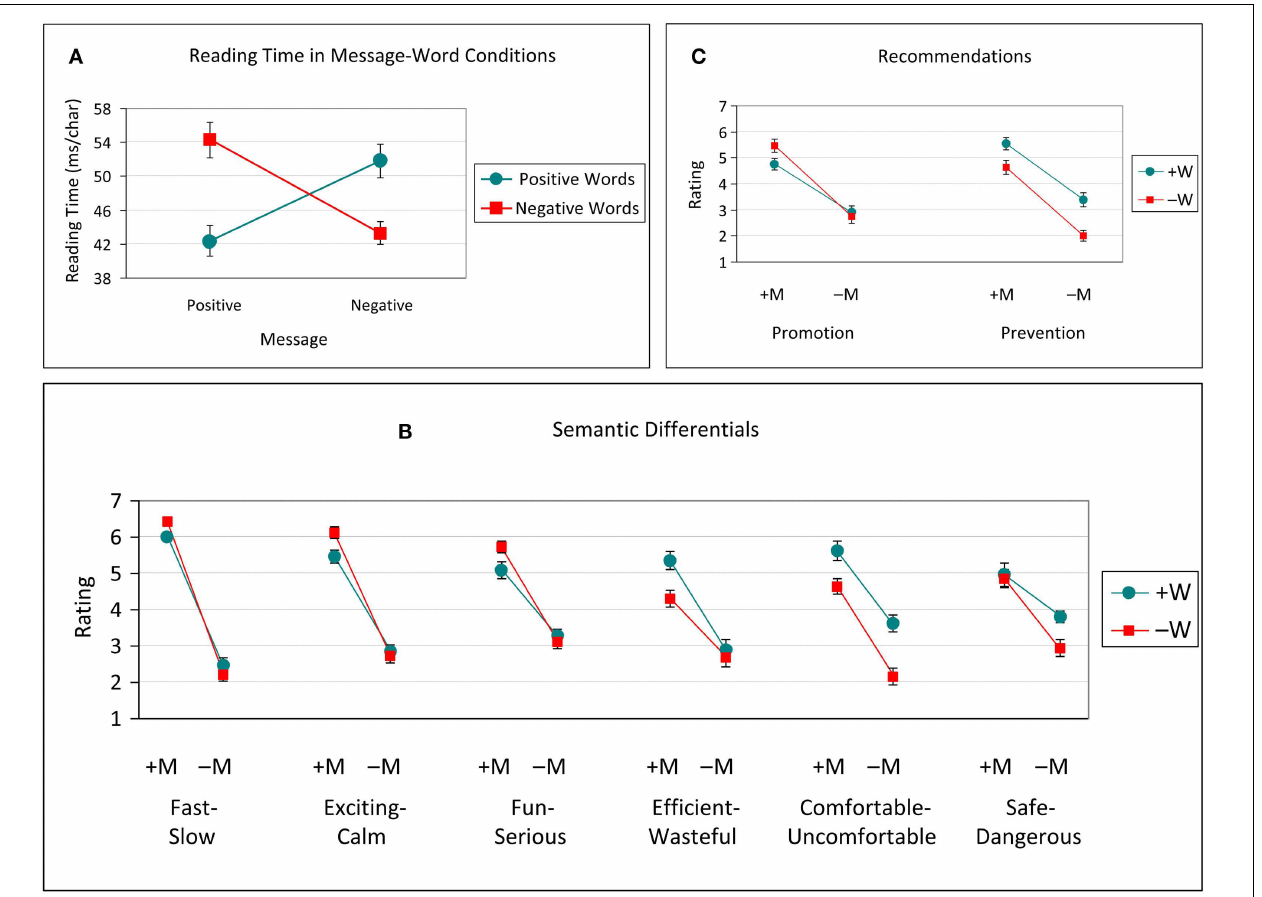
FIGURE 4 | Replication study averages (with standard error bars) across measures and conditions. (A) , reading time (ms/char) across Message (M) × Word (W) conditions. (B) , semantic differential ratings across M × W conditions. M andW conditions were either Positive ( + ) or Negative ( − ).